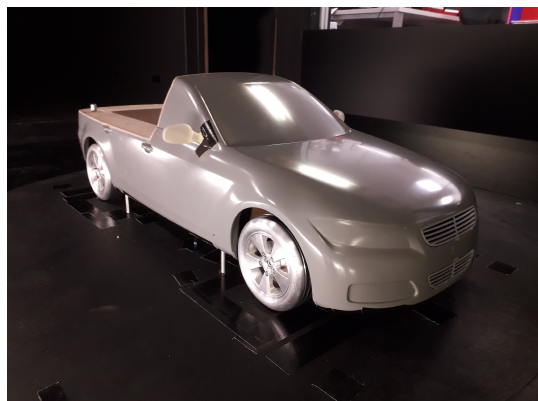
Figure 3. The DrivAer model installed in the Loughborough University Large Wind Tunnel without a rear